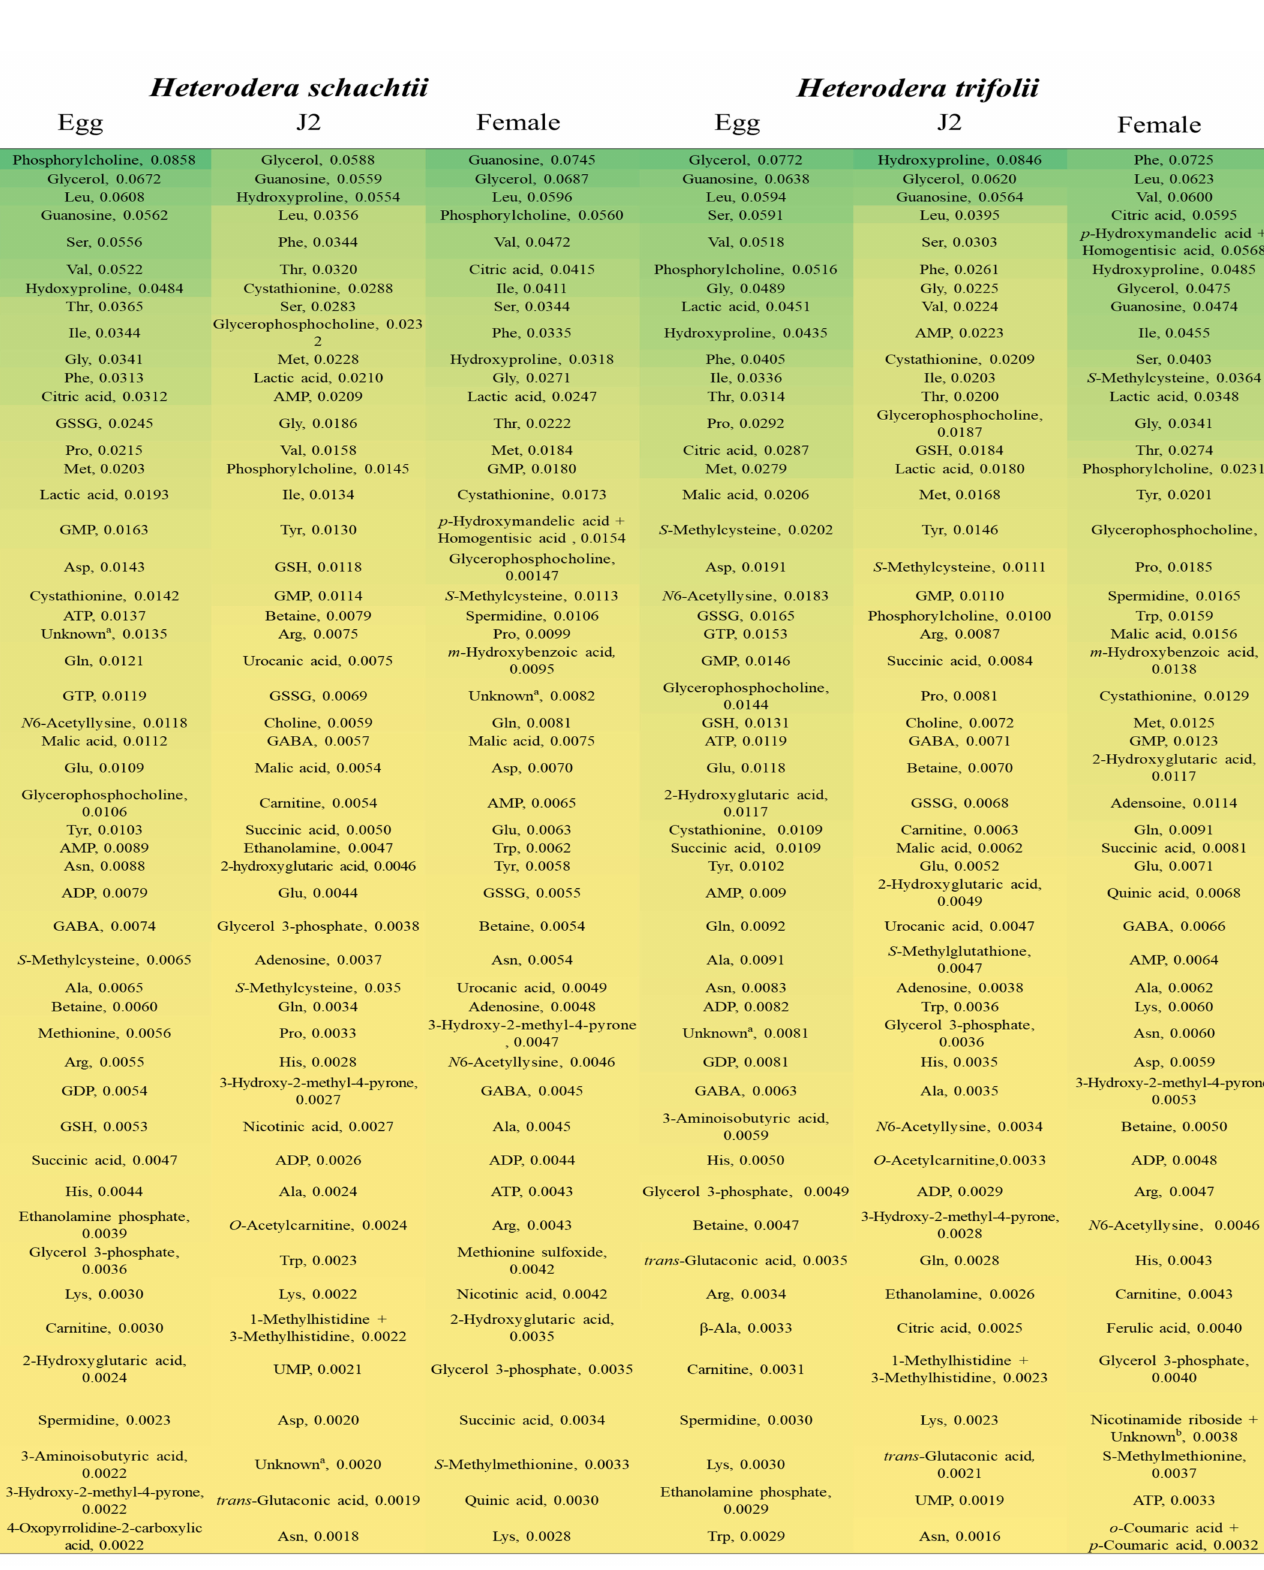
Figure 2. Top fifty metabolites in the egg, juvenile 2 (J2), and female stages of H. schachtii and H. trifolii nematode species arranged in descending order (top to bottom) of relative peak area (mg − 1 ). Refer to Table S2 for abbreviations of metabolites. The unknown metabolites XA0033 ( a ) (S/NO, 355; Table S2) and XC0089 ( b ) (S/No, 365; Table S2) had predicted m / z values of 242.080 and 255.099,